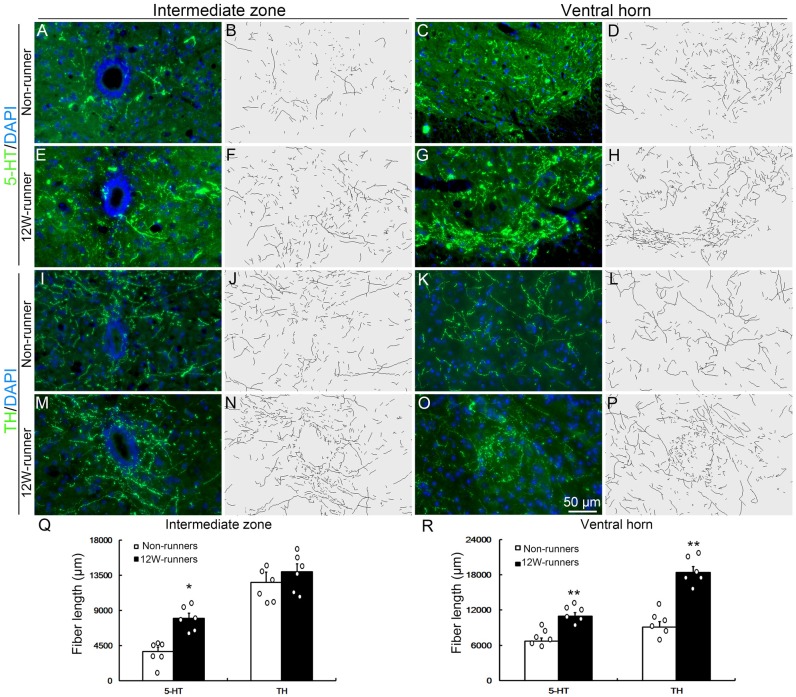
Monoaminergic fibers in the spinal cord are increased after training. (A–P) Intermediate zone and ventral horn of spinal cord at C5–C7 segments, stained with anti-serotonin (anti-5-TH, A–H) and anti-tyrosine hydroxylase (anti-TH, I–P) antibodies, with outline of fiber patterns upon 3D reconstruction. (Q,R) Quantification of fiber length in intermediate zone and ventral horn. Each circle represents the data from one animal. *P < 0.05; **P < 0.01; n = 6 for each group.